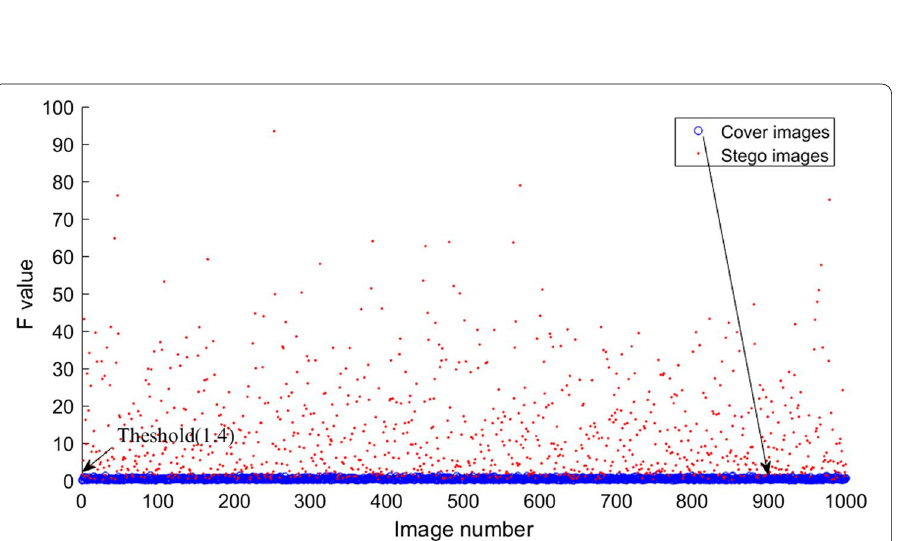
Fig. 11 Distribution of the cover and stego images with an embedding ratio of 10% (type 2 of the PVD